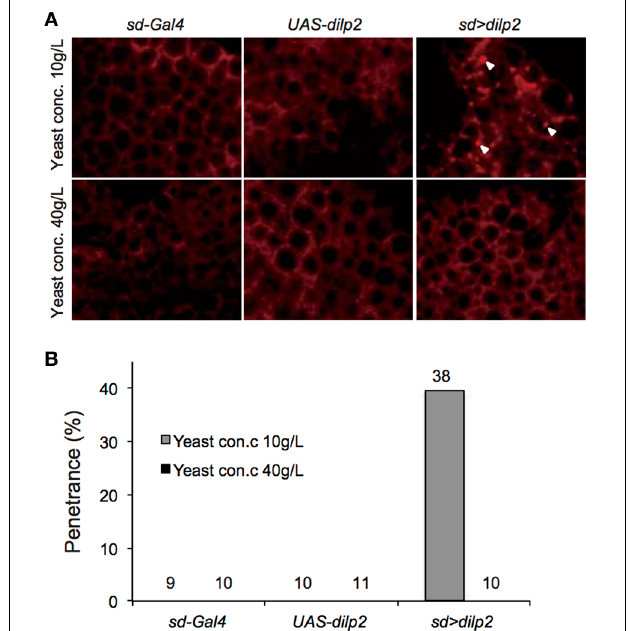
FIGURE 10 | Intensive autophagy in dilp2 -overexpressing flies. Fat bodies were dissected from early third instar larvae overexpressing dilp2 ( sd > dilp2 ) and stained with LysoTracker Red DND-99 (A) . When the flies were reared on standard media containing 10g yeast/L, strong punctate signals (arrowheads), corresponding to autophagy were observed in the sd > dilp2 flies (upper right panel) but not in the parental lines ( sd-Gal4 or UAS-dilp2 ) as the controls (upper left and middle panels). Autophagy was not detectable in the sd > dilp2 flies when they were reared on protein-rich media containing 40g yeast/L (lower panels). The penetrance (frequency) of ectopic autophagy in sd > dilp2 flies (B) . Numbers of samples observed were indicated above each